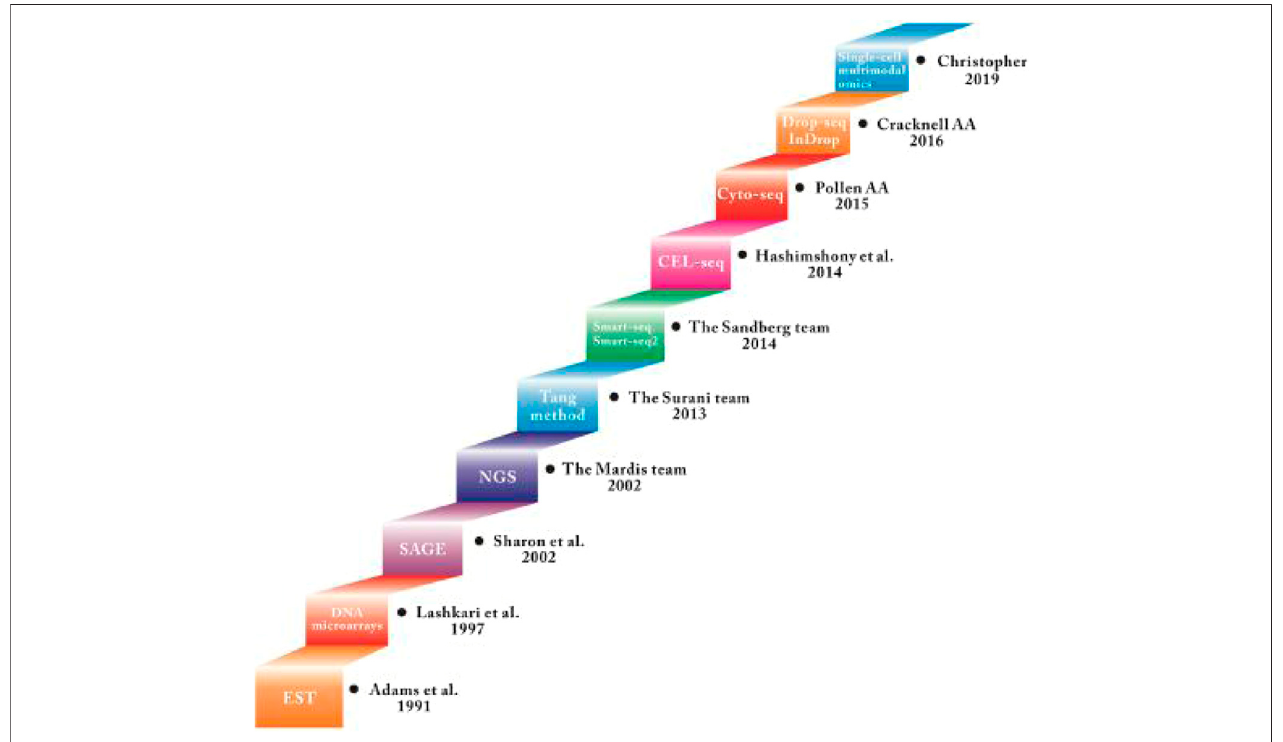
FIGURE 1 | Summary of the development of Single-cell RNA sequecing